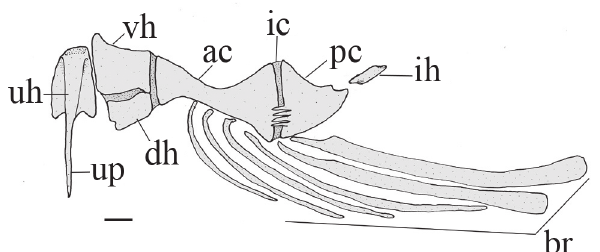
Fig. 4. Right hyoid arch of Glanidium botocudo , MNRJ 32539, paratype, 82.0 mm SL. Ventral view. Abbreviations: ac, anterior ceratohyal; br, branchiostegal rays; dh, dorsal hypohyal; ic, interceratohyal cartilage; ih, interhyal; pc, posterior ceratohyal; vh, ventral hypohyal; uh, urohyal; up, urohyal ventral process. Scale bar = 1.0 mm.